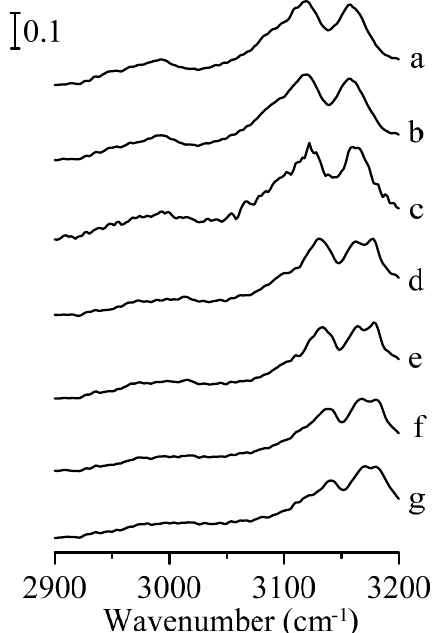
Figure 5. Infrared spectra of Al 2 O 3 /1-ethyl-3-methylimidazolium trifluoromethanesulfonate mixture obtained under ambient pressure (curve a) and at 0.4 (curve b), 0.7 (curve c), 1.1 (curve d), 1.5 (curve e), 1.8 (curve f), and 2.5 GPa (curve g).